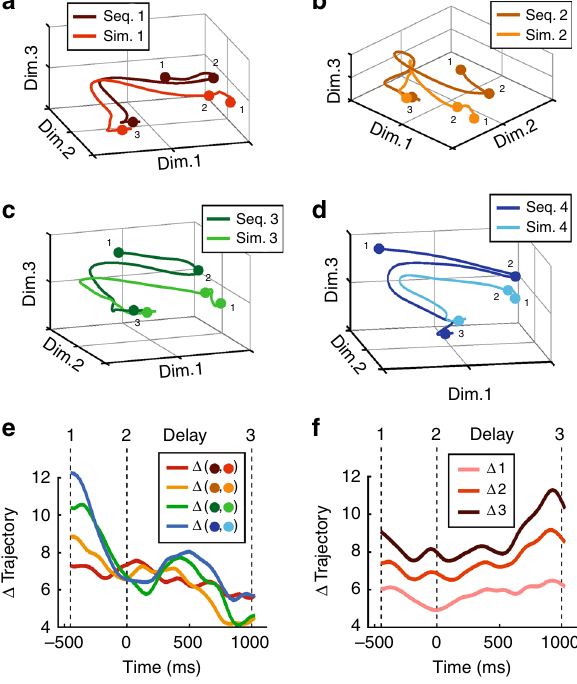
Fig. 7 State-space analysis of delay response dynamics. a – d State-space trajectories for numerosities 1 ( a ), 2 ( b ), 3 ( c ), and 4 ( d ). Trajectories depict the route separately for sequential and simultaneous presentation formats. During onset of the last 500 ms in the sample period (1) and at delay onset (2), responses to the two formats vary from each other. Over the course of the delay, representations converge until the test comes up (3). Euclidean distances between e sequential and simultaneous trajectories separately for the four numerosities, and f between the trajectories of the different sample numerosities. Distances were averaged over pairs with the same numerical distance. Euclidean distances were calculated over all 37 dimensions. Time point 0 ms is delay